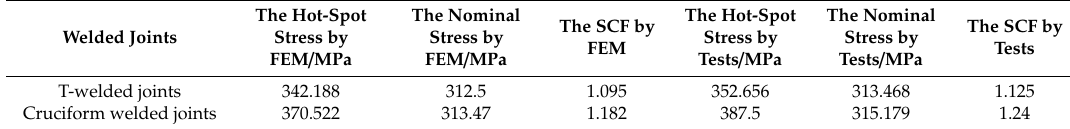
Table 6. Comparison of stress concentration factors between the finite element method (FEM) and tests.